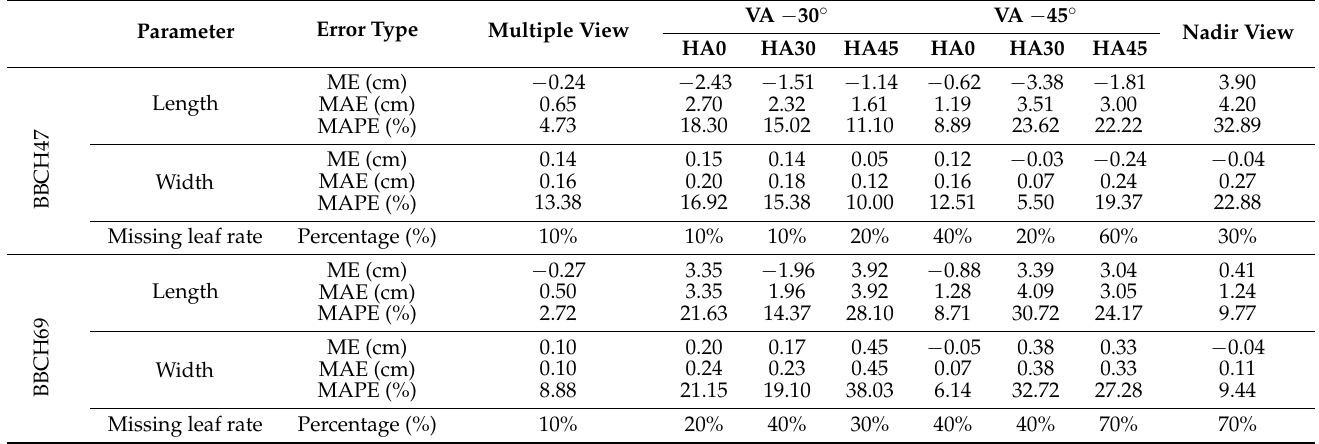
Table 2. Summary of leaf accuracies and missing leaf rate for the reconstructed